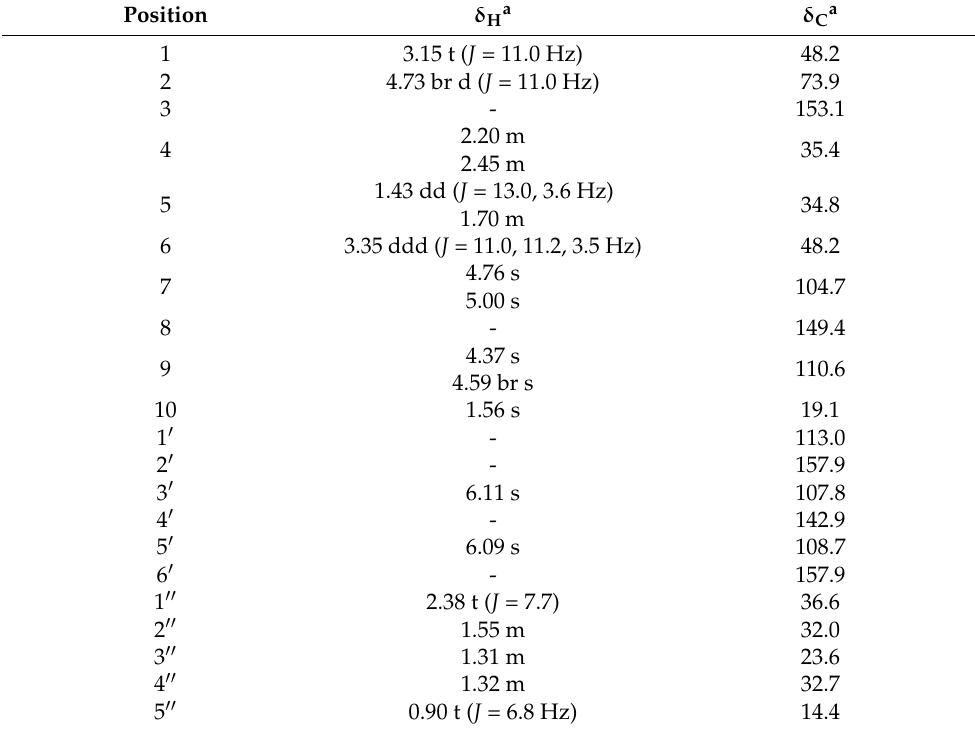
Table 1. 1 H (400 MHz) and 13 C (100 MHz) NMR data of compound 1 in CD 3